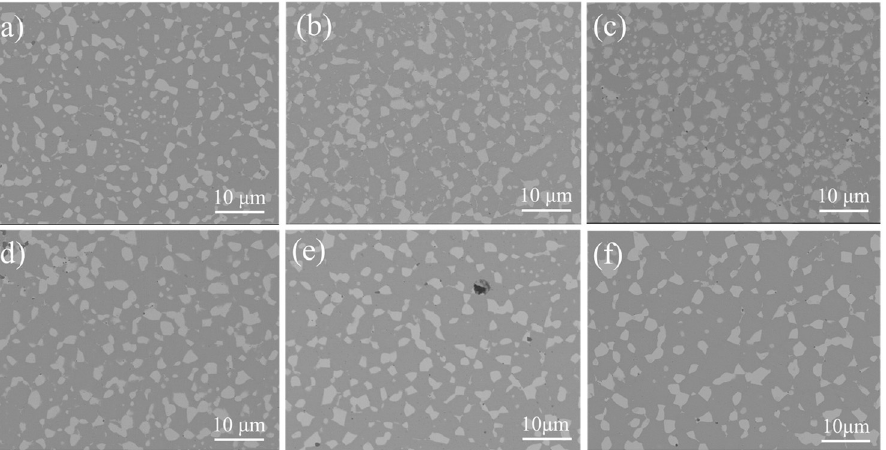
Figure 10: The SEM - BSE images of the microstructure in as - annealed alloys: ( a ) M - 80 alloy, ( b ) M - 85 alloy, ( c ) M - 90 alloy, ( d ) H - 110 alloy, ( e ) H - 115 alloy, and ( f ) H - 120 alloy.